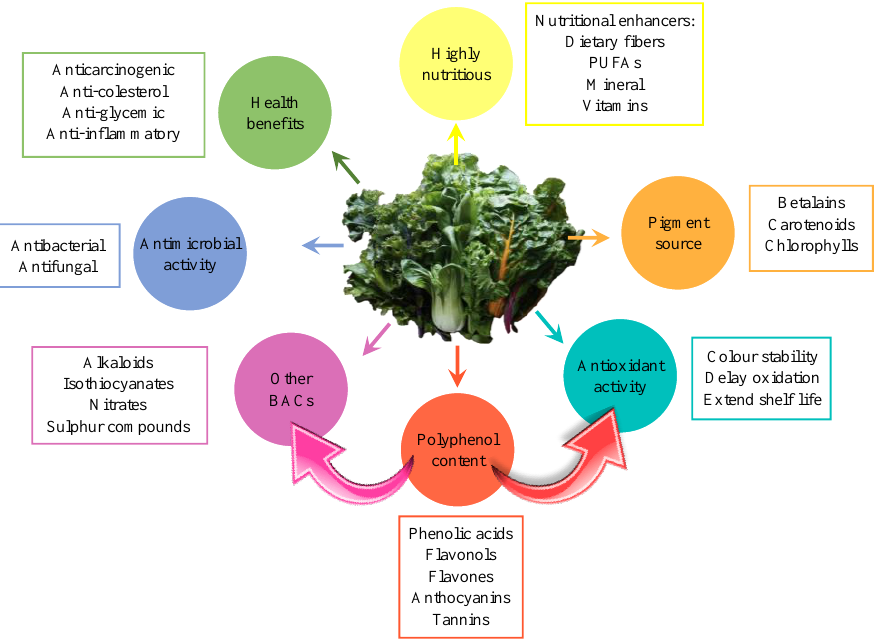
Figure 1. Nutritional, physicochemical properties and bioactivity associated to leaf vegetables.